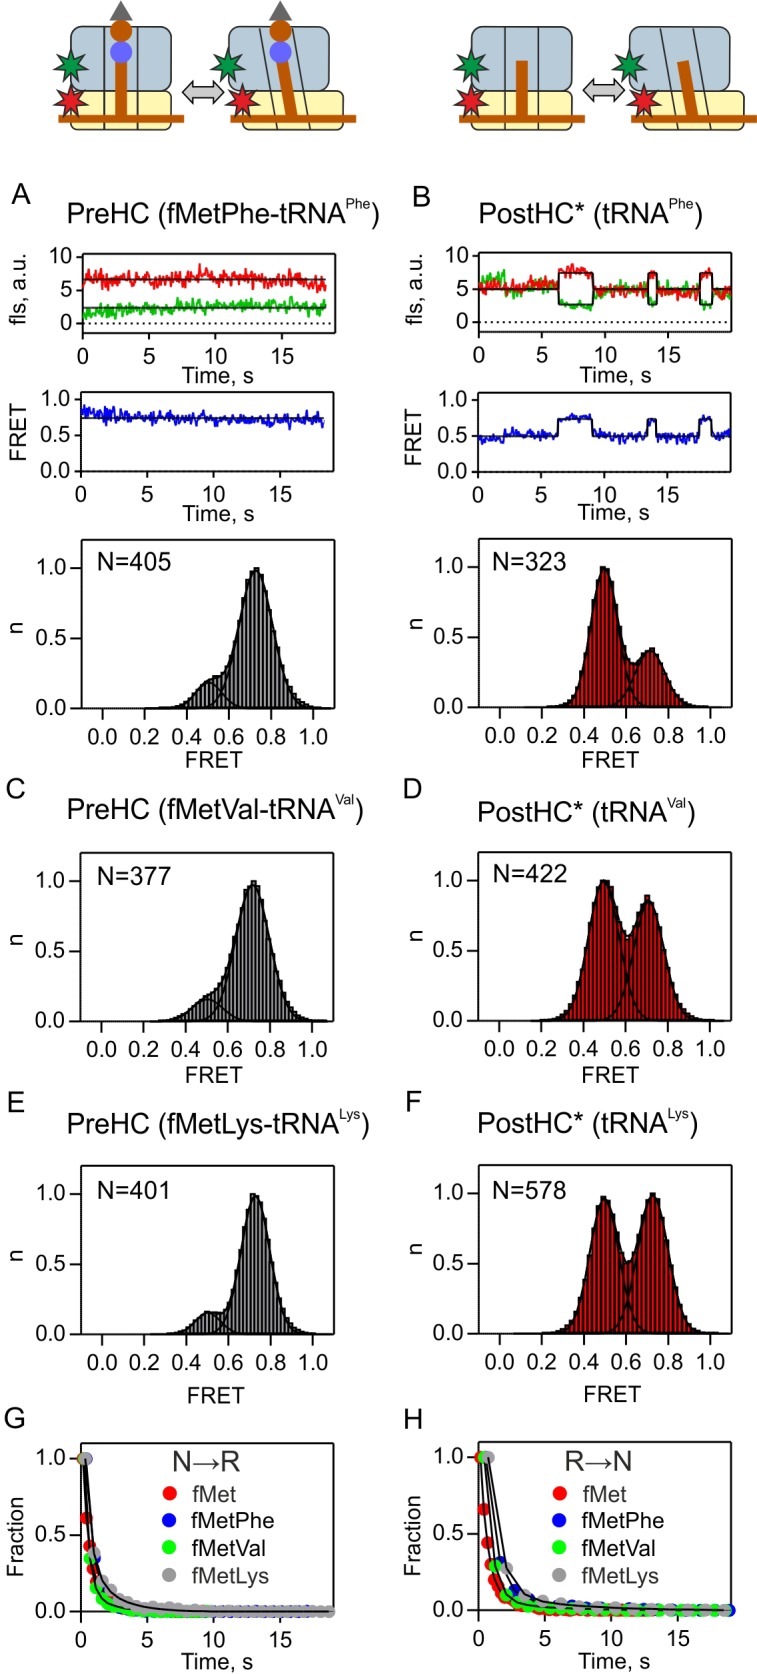
Subunit rotation of termination complexes in the absence of release factors.FRET signals monitored using S6/L9-labeled PreHC (A,C,E) and PostHC* (B,D,F) with different tRNAs in the P site. PostHC* was generated by addition of puromycin (1 mM) to PreHC. (A,B) Representative examples of time courses are shown for fMetPhe-tRNAPhe and tRNAPhe (C–F). Histograms showing the normalized distribution of FRET states. N is the number of traces entering the histogram. (G,H) Dwell time distributions obtained from the Hidden-Markov fits of FRET time traces. Transition rates from the N to the R state (kN→R) and from the R to the N state (kR→N) were determined by exponential curve fitting of the dwell-time distribution histograms. FRET values and rate constants (mean ±sd) were calculated from three independent data sets and are summarized in Supplementary file 1.